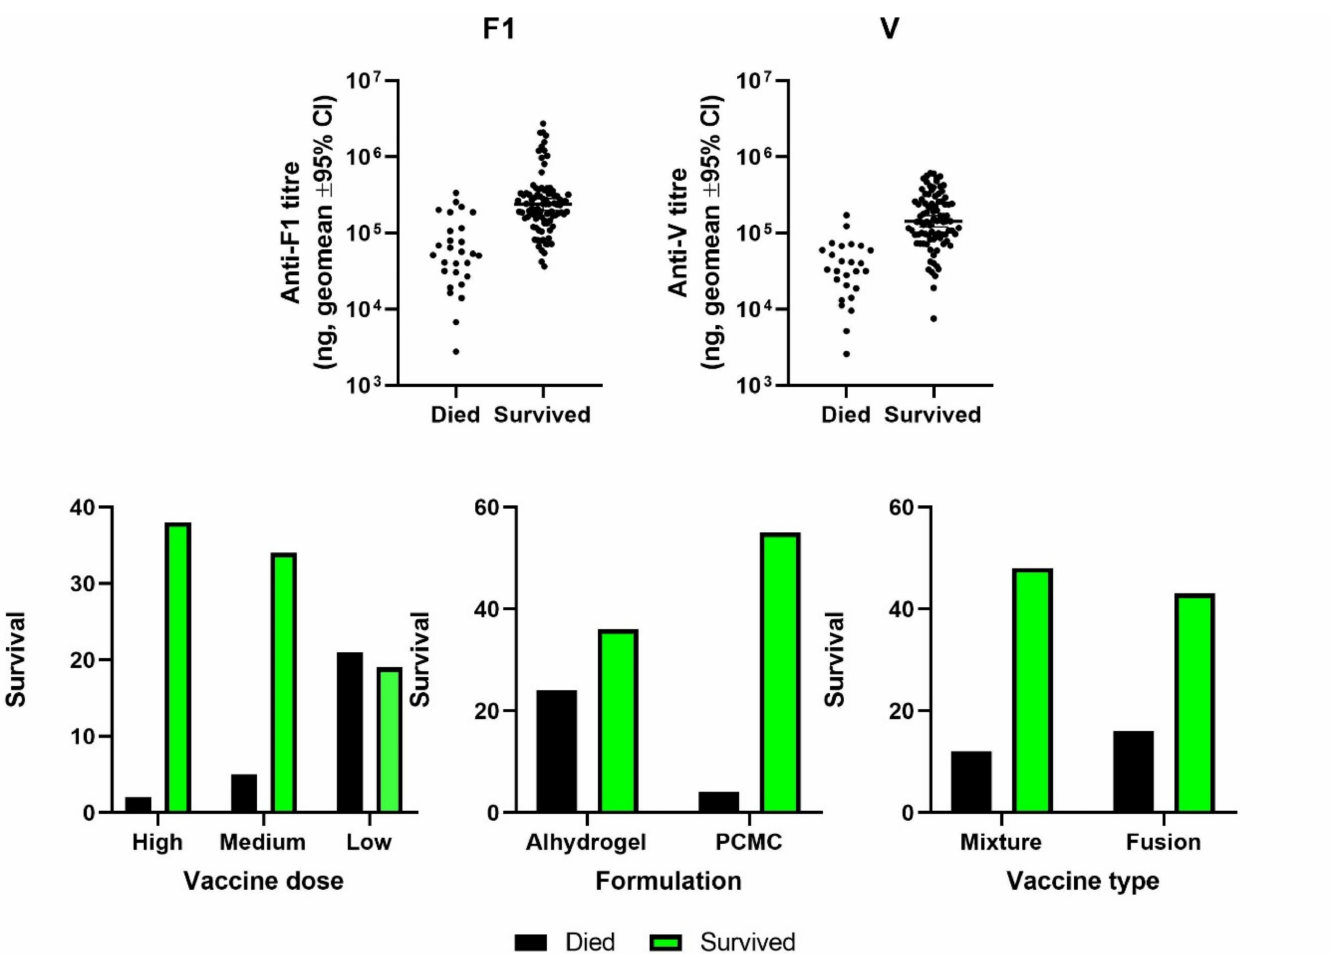
Figure 3. The factors that correlate with survival in mice immunised against Y. pestis . Top panel shows antibody titres raised against F1 (left) and V (right); lower panel shows the frequencies for animals in the study that died and survived when the vaccine was delivered at different concentrations (left), with different formulations (middle) or as a fusion or mixture of antigens (right). For F1, formulation in PCMC/alhydrogel interacted with dose level ( p = 0.02) to influence survival, but both vaccine types were equally efficacious in this formulation. For V, antibody titre and dose level interacted to